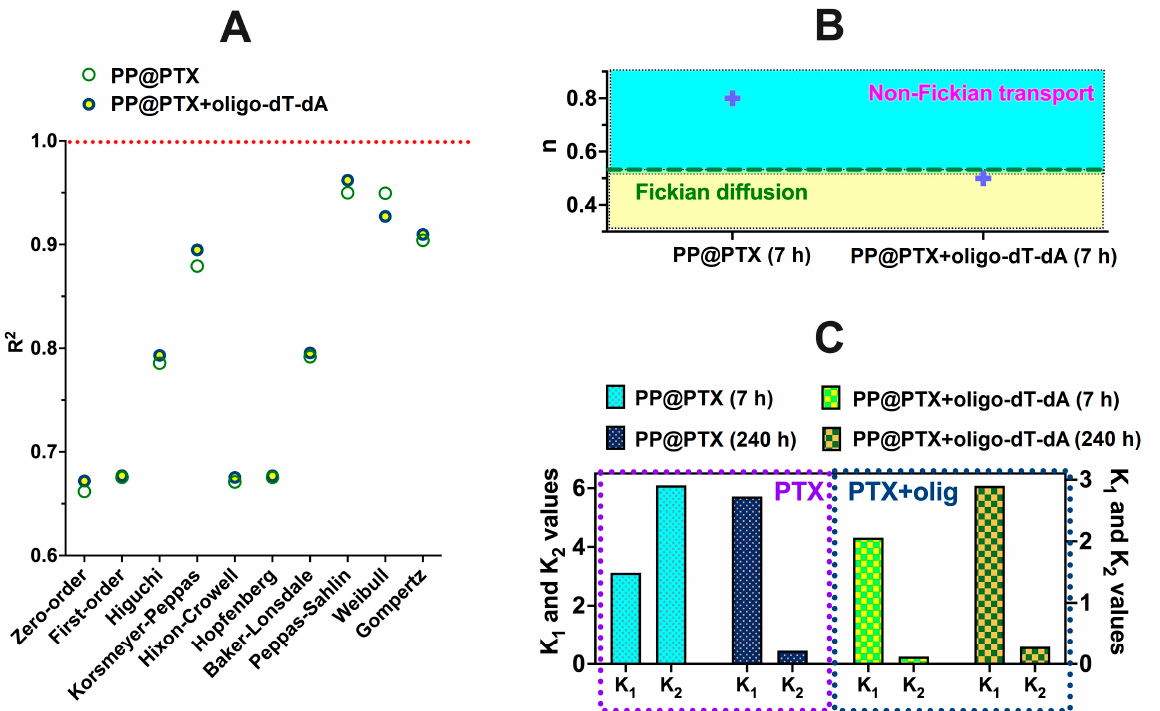
Figure 10. Effect of co-encapsulation of PTX and oligo-dT-dA on the mechanism of PTX release from P[KK(Y)K(R)]-based delivery systems, evaluated with the application of various mathematical modeling: ( A ) comparison of correlation coefficients of the regressions obtained with different models for the release of PTX from single- and dual-component systems during 240 h; ( B ) effect of oligo-dT-dA co-encapsulation on the n parameter evaluated from the Korsmeyer–Peppas model; ( C ) results obtained by application of the Peppas–Sahlin model, where K 1 is the impact of diffusion and K 2 is the impact of relaxation on the release mechanism.